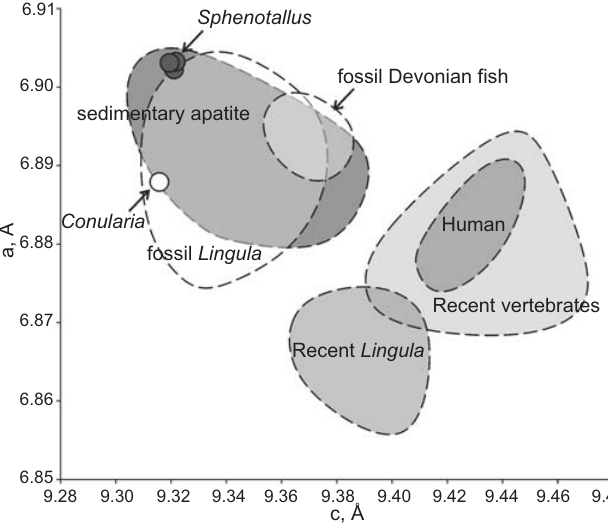
Fig. 5. Lattice parameters of Sphenothallus aff. longissimus apatite com- pared with Conularia sp. and other biological and sedimentary apatites (data from Nemliher